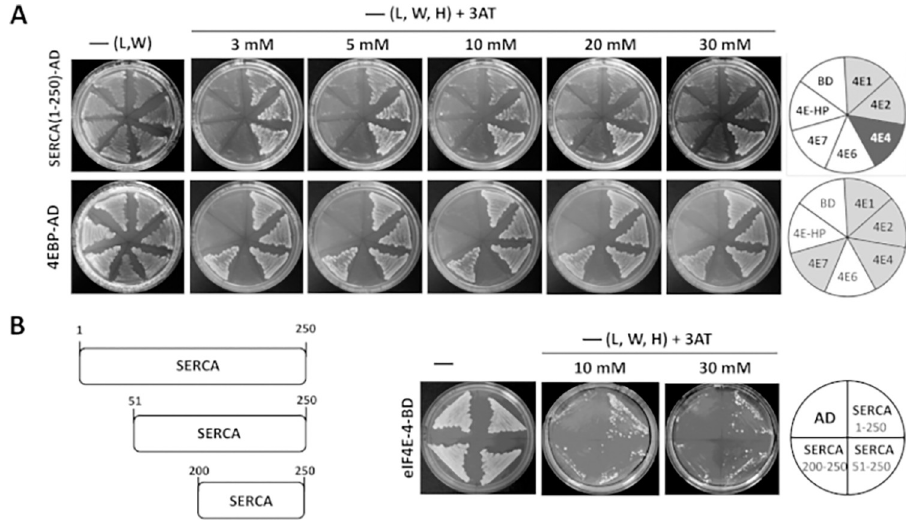
Fig 4. SERCA interacts with eIF4E-4, eIF4E-1 and eIF4E-2 in the yeast two-hybrid system. A) “Prey” SERCA (amino acids 1–250)-activator domain (AD; upper panel) interacts with “baits” eIF4E-4, eIF4E-1 and eIF4E-2 in a yeast two-hybrid assay. eIF4E-4 exhibits the strongest interaction. “Prey” 4E-BP-AD (lower panel) was used as a positive control. Empty vector (BD) was used as a negative control. B) pSERCA(51–250)-AD, but not pSERCA(200– 250)-AD, interacts with eIF4E-4-BD. L, leucine; W, tryptophan; H, histidine; 3AT, 3-amino-1,2,4-triazole.–(L,W), growth control. Interactions were tested under increasing astringency conditions (3 to 30 mM 3-amino-1,2,4-triazole,